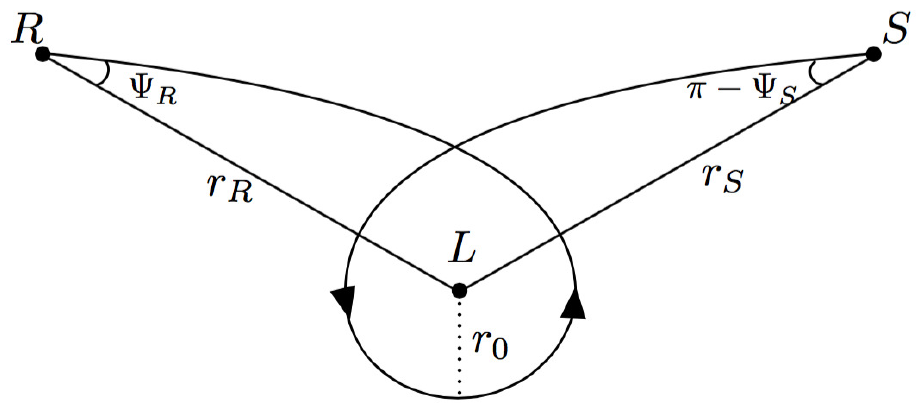
Figure 4. A one-loop case for the photon orbit in M opt